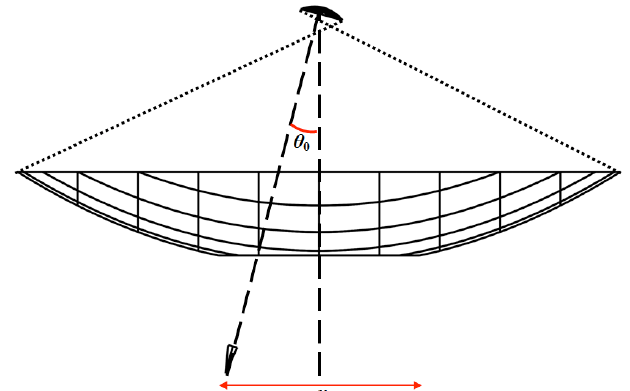
Figure 6: Optical arrangement of an off-axis Gregorian